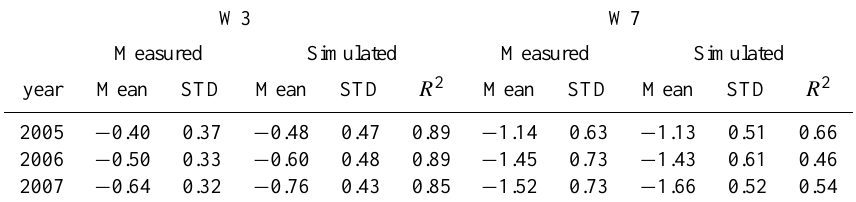
Table 4b. Measured and simulated water table for automatic wells in 2005–2007 a . W3 W7 Measured Simulated Measured Simulated year Mean Mean